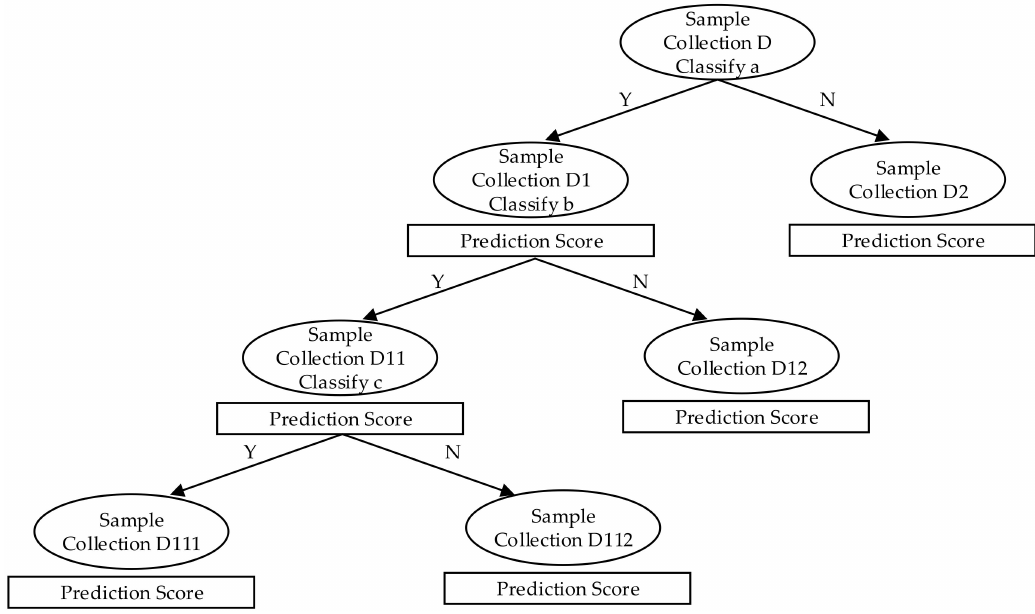
Figure 2. Classification and Regression Tree